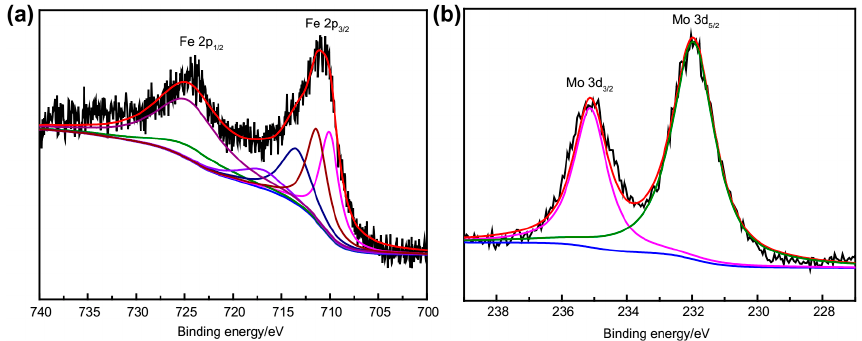
Figure 4. XPS spectra of ( a ) Fe 2p and ( b ) Mo 3d of Fe 3 O 4 @ 1 .